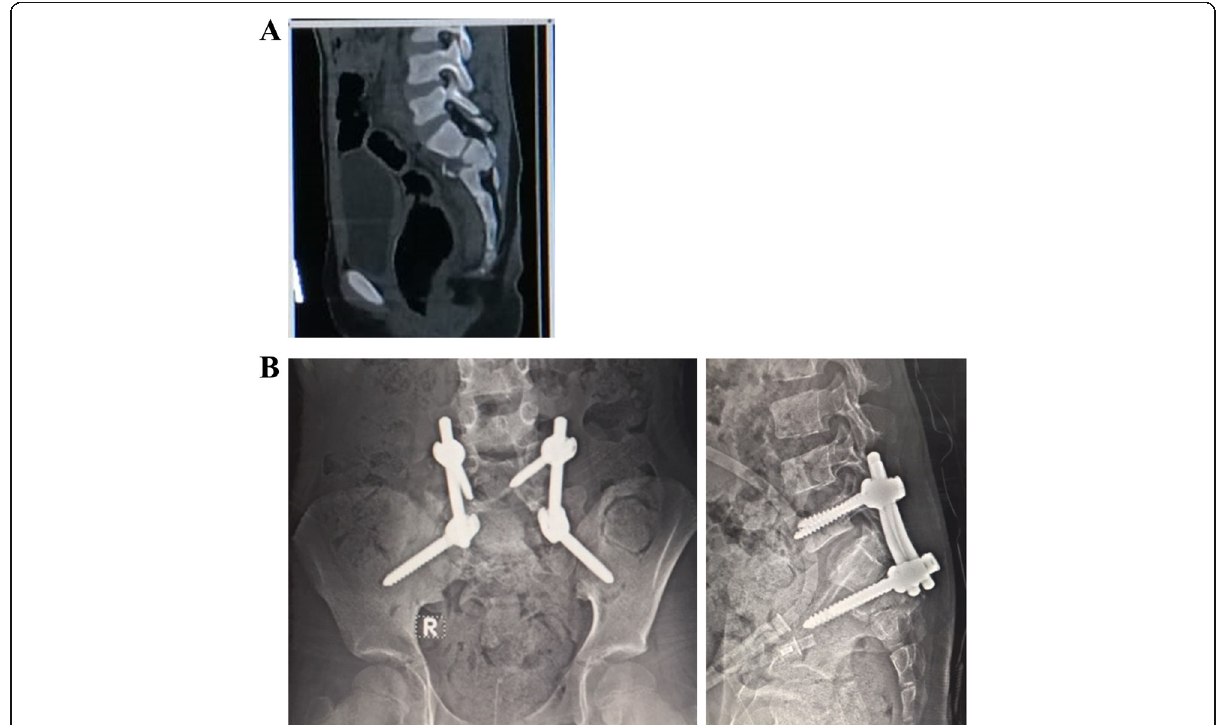
Fig. 1 a A sagittal midline CT image of the lumbosacral spine region showing a sacral fracture in an 11-year-old female. b Three months postoperative AP and lateral plain X-ray images of the lumbosacral spine region showing the lumbopelvic fixation through the use of a 50-mm S2 alar-iliac screw after decompression of the sacral